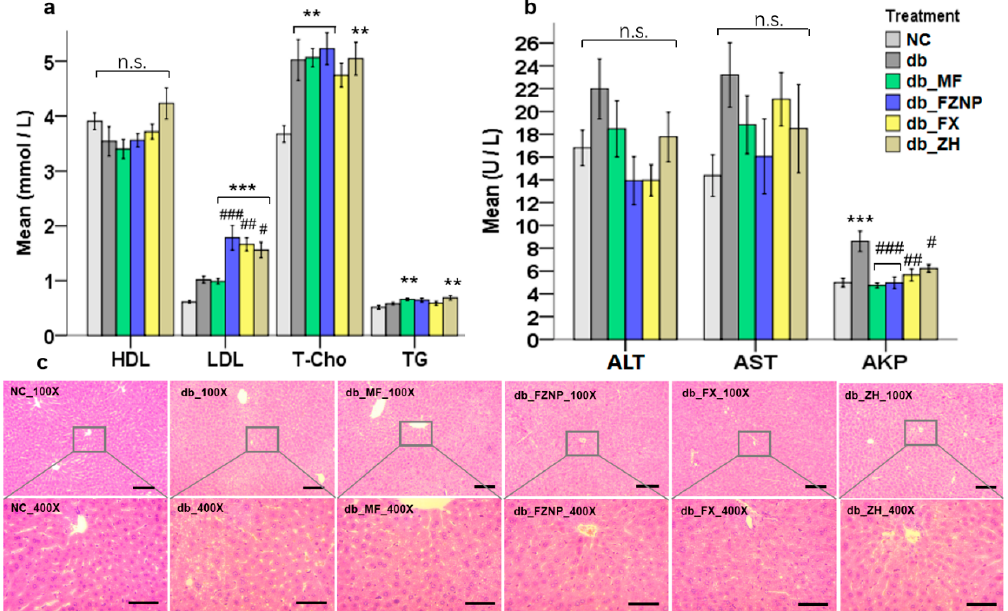
Figure 3. Biochemical tests in serum and Histology of Hepatocyte. The level of HDL, LDL, T-Cho and TG in the serum of mice ( a ). The value of ATL, AST and AKP in serum ( b ). The asterisk including ** ( p ≤ 0.01), and *** ( p ≤ 0.001) indicate the significant difference compared with the NC group. The hashes including # ( p < 0.05), ## ( p ≤ 0.01) and ### ( p ≤ 0.001) indicate the significant difference from the db group. Microscopy images of H&E-stained liver tissues ( c , 100× scale bar 100 μ m, 400× scale bar 50 μ m).